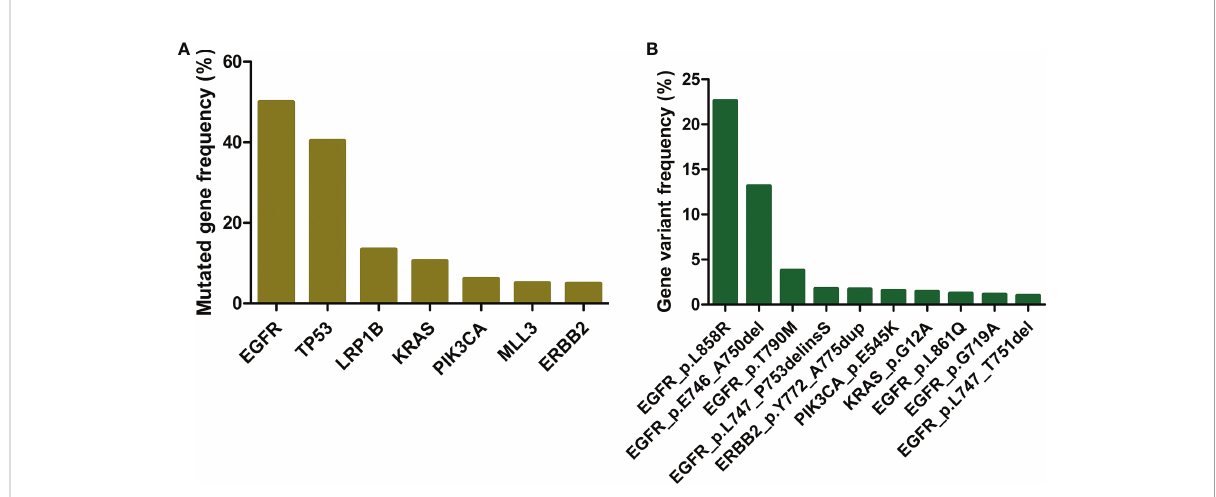
FIGURE 2 Recurrence of genes and mutations. (A) Mutated gene frequency among all patients. (B) Gene variant frequency among all patients.